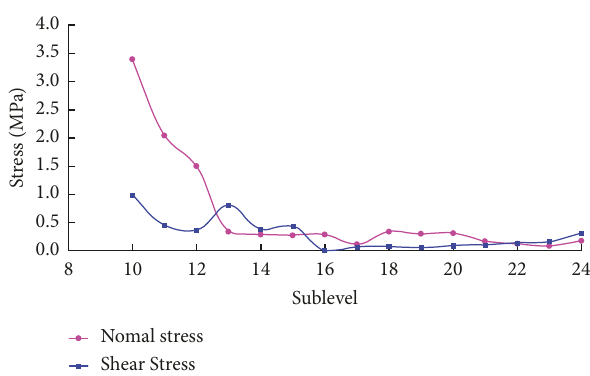
Figure 7: Relationship of the stress state of fault F2 with the mining depth.